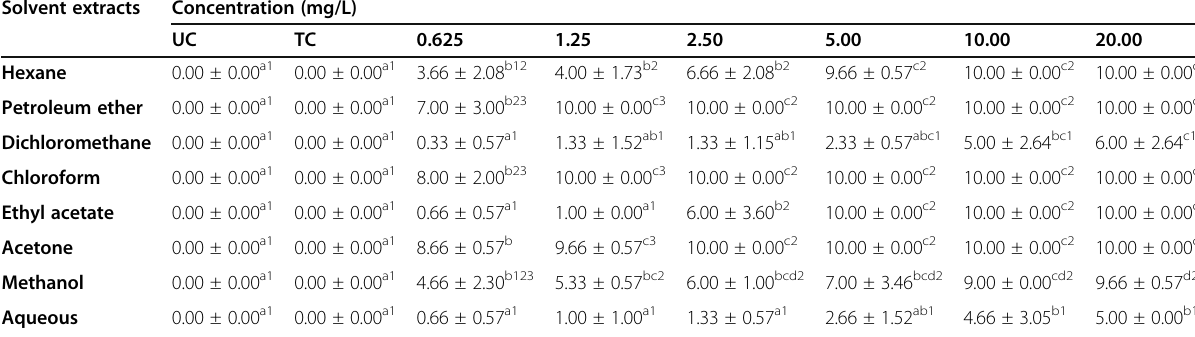
Table 5 Adulticidal activity of Nicotiana tabacum leaf extracts against Sitophilus oryzae at 72 h Solvent extracts